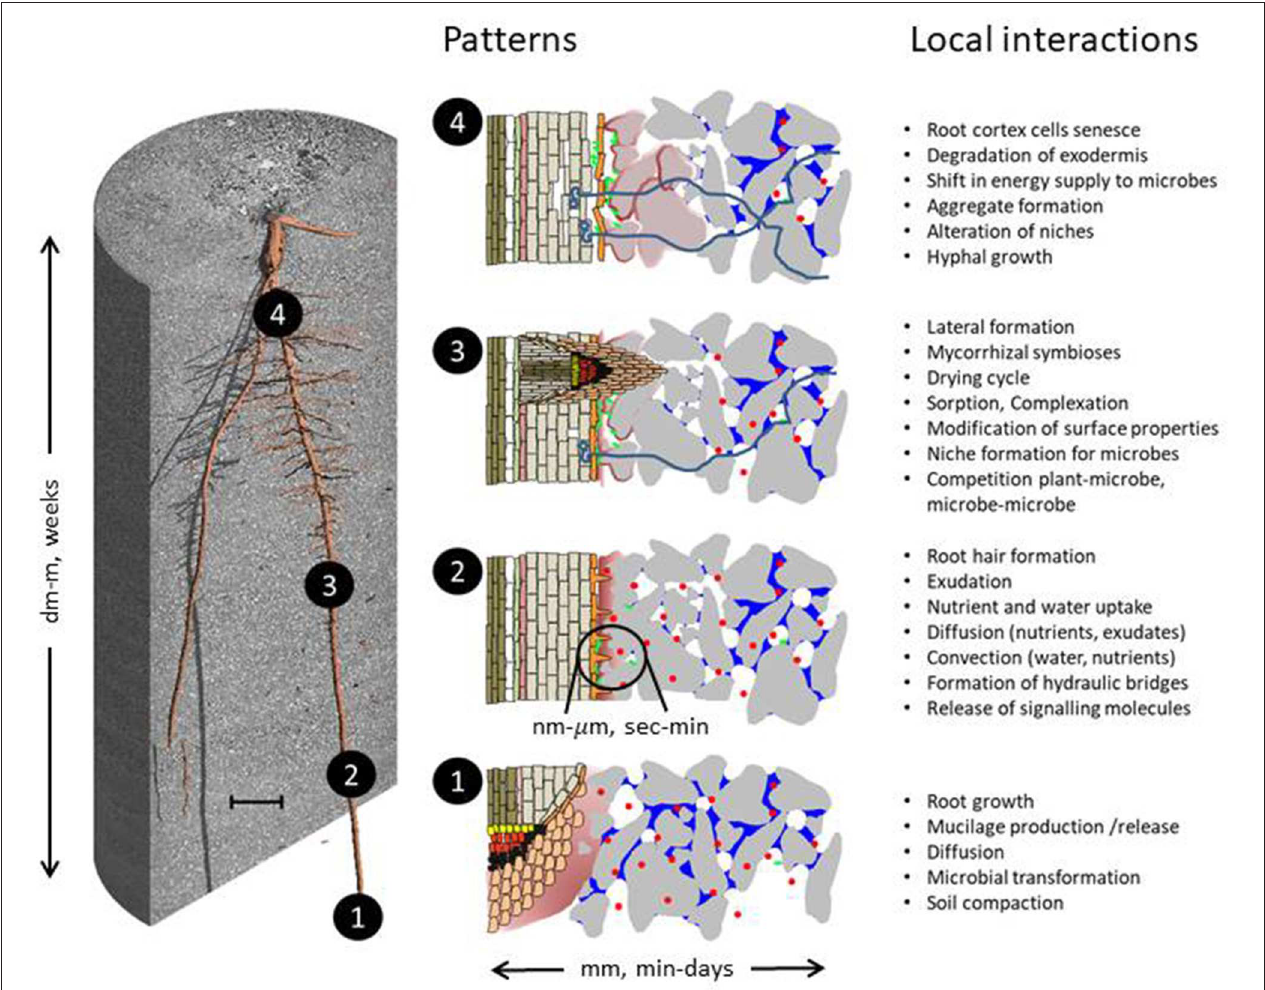
FIGURE 1 | Hypothetical patterns reflecting rhizosphere self-organization based on numerous feedback loops resulting from local interaction of lower-level components. Illustrated are mucilage (rose) and water distribution (blue), compaction of soil particles (gray) and aggregate formation (gray-rose), colonies of microorganisms (green), depletion of phosphorous (red) and their potential change with root ontogeny. The latter is illustrated on the left for a 7-day old Zea mays root system growing in loam (scale bar 10mm). Note that the patterns are not to scale. Local interactions/mechanisms are sorted according to their potential relevance at a certain developmental stage—not suggesting that they are absent at other stages. The integration of patterns for the whole root system is expected to determine emergent properties like water and nutrient acquisition, soil structure, and carbon storage as well as plant